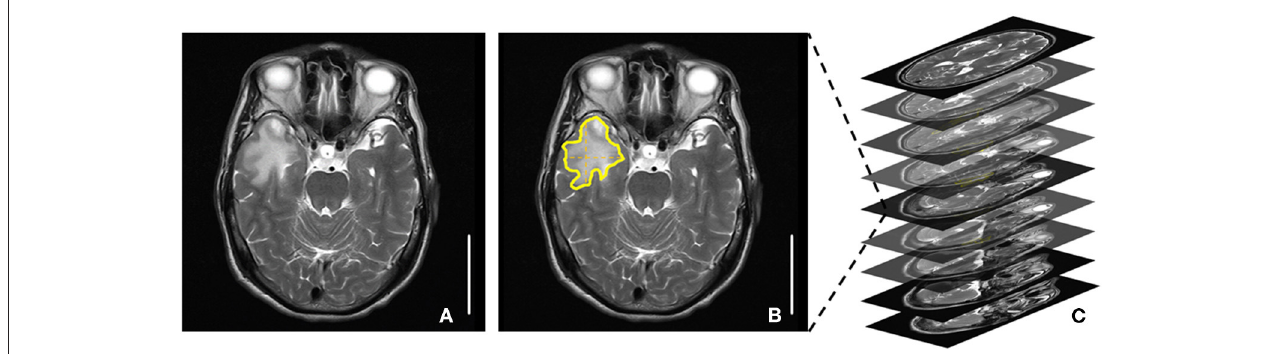
FIGURE 1 | Radiation encephalopathy lesion volume measurements. (A) A T2 magnetic resonance imaging (MRI) image with the largest lesion area. (B) The largest lesion area: area surrounded by yellow lines. (C) The number of T2 MRI images with lesions. The RE lesion volume = the largest lesion area × the number of T2 MRI images with lesions.